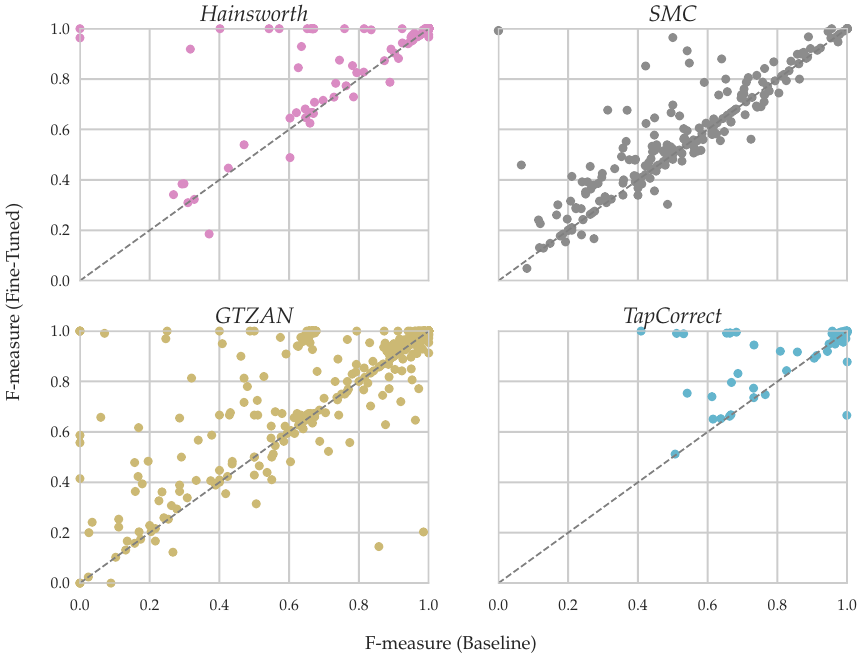
Figure 4. Comparison of the F-measure for the baseline and fine-tuning approaches on in-training datasets Hainsworth and SMC and out-of-training datasets GTZAN and TapCorrect